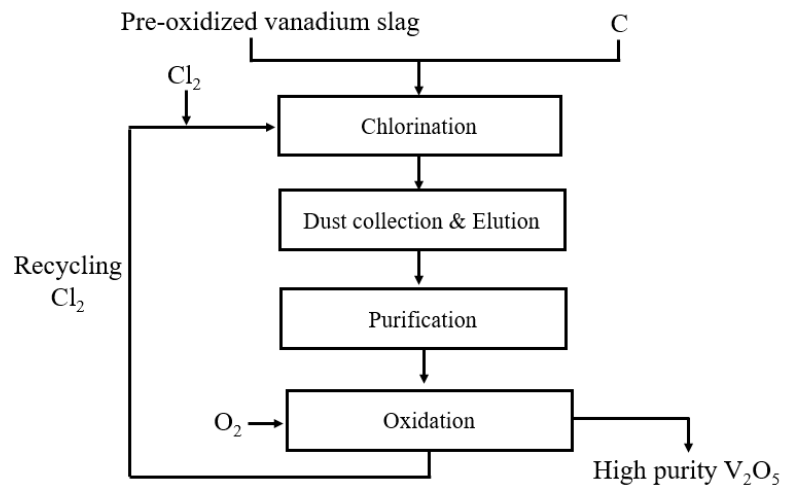
Figure 6. Flow chart of extracting vanadium from vanadium slag by carbochlorination. In order to extract vanadium from vanadium slag, Liu et al. [49–55] proposed to use selective chlorination method to extract vanadium. Because to the existence form and value of valuable metal elements (Fe, Mn, V, Cr and Ti) in vanadium slag, NH 4 Cl was selected to chlorinate Fe and Mn in vanadium slag. Thermodynamic calculations show that the iron and manganese in vanadium slag could be chlorinated by hydrogen chloride, but the V, Cr and Ti could not be chlorinated in the temperature range from 0 to 1000 ◦ C. Under optimal chlorination conditions, the chlorination ratio of iron and manganese were 72% and 95%, respectively. Meanwhile, the enrichment ratio of V, Cr and Ti was obtained as 48%. In addition, AlCl 3 was selected to chlorinate V, Cr and Ti in vanadium slag. Figure 7 shows a flow chart of extracting vanadium from vanadium slag by AlCl 3 chlorination. The chlorination temperature is about 900 ◦ C. Vanadium after chlorination exists in the form of VCl 3 . Metal V was obtained by molten salt electrolysis at 900 ◦ C. The effects of reaction temperature, reaction time, mass ratio of AlCl 3 /slag and mass ratio of salt/AlCl 3 on the chlorination ratio of valuable elements were investigated. Under optimal